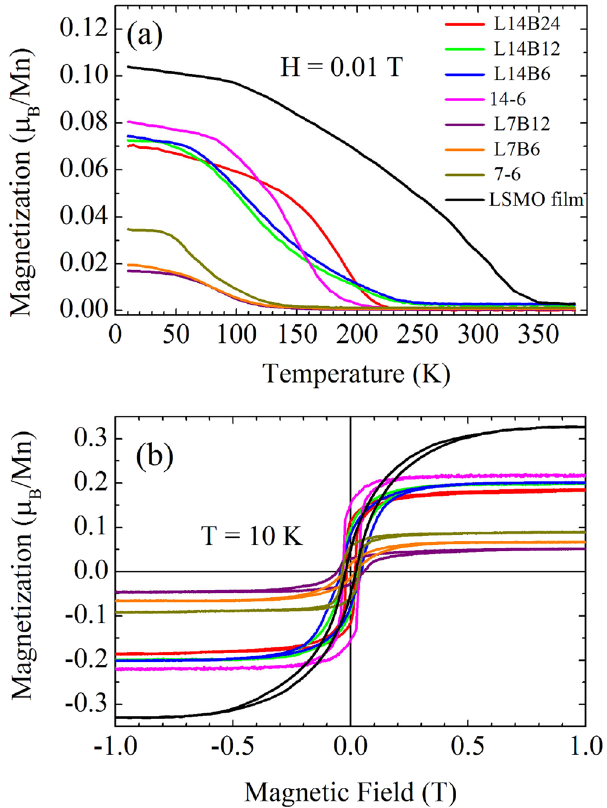
Figure 4. ( a ) Magnetization as a function of temperature for the LSMO/BSTO SL series and LSMO film. Magnetization was measured at field-cooled mode in a magnetic field of 0.01 T. ( b ) Magnetization as a function of field for the LSMO/BSTO SL series and LSMO film at 10 K. Magnetization is normalized by the volume of the LSMO layer.